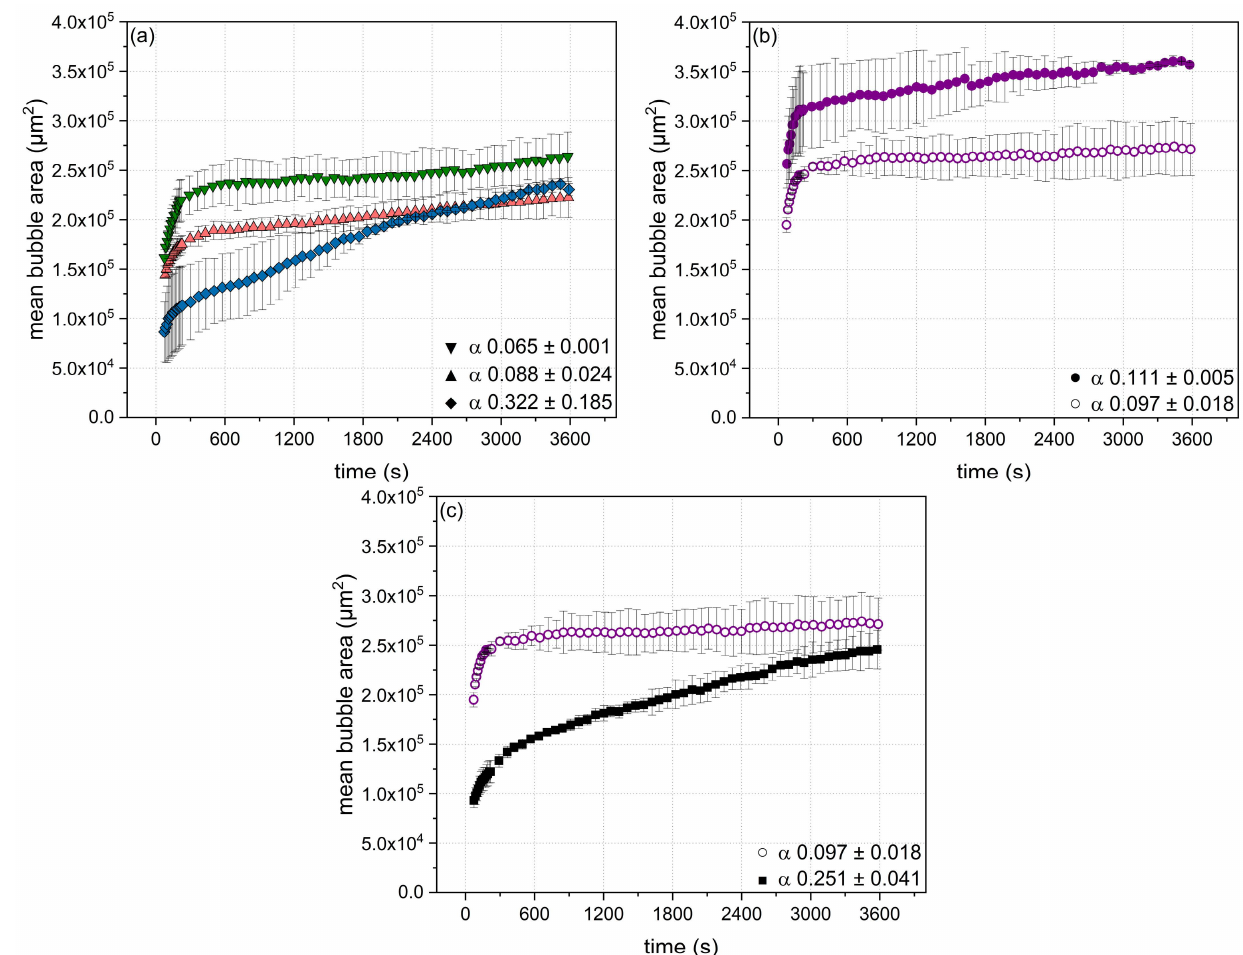
Figure 3. Evolution of the mean bubble area in dependence of time as a function of the β -Lg particle (c = 8.2 g L − 1 ) physicochemical properties: ( a ) varying degree of cross-linking ( (cid:72) 85, (cid:78) 92, and (cid:7) 109%) but similar size (~22 nm) and similar zeta potential (~ − 30 mV); ( b ) varying zeta potential ( degree of cross-linking (104%); ( c ) varying size ( (cid:4) 3 and similar zeta potential (~ − 30 mV) including the coarsening factor α . Error bars indicate standard